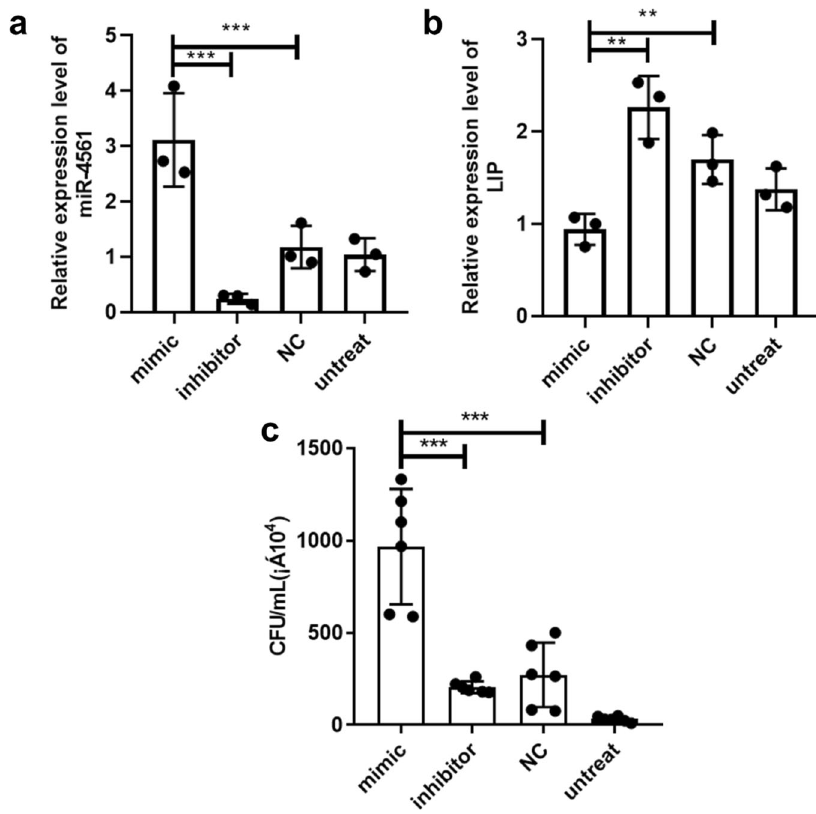
Fig. 6 In vivo overexpression of miR-4561 mimics decreases V. anguillarum clearance. a Relative expression level of miR-4561 after transfection in vivo. b Relative expression level of lip . c In vivo bacterial clearance after miR-4561 mimics and inhibitor transfection (** P < 0.01, *** P <